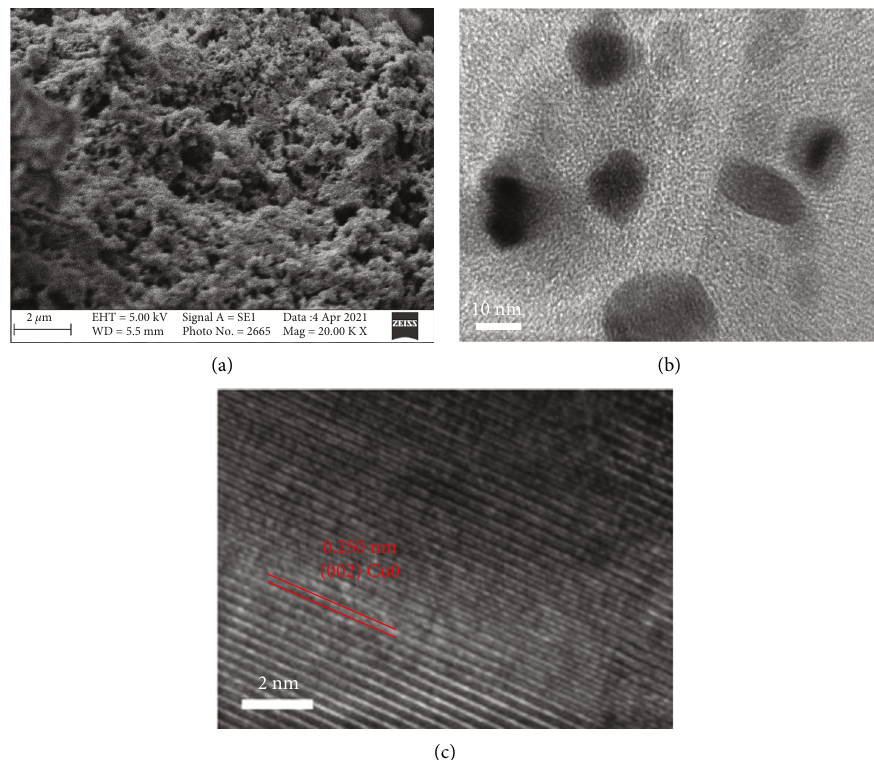
Figure 2: (a) SEM of CuO@NDC, (b) TEM of CuO@NDC, and (c) HRTEM of